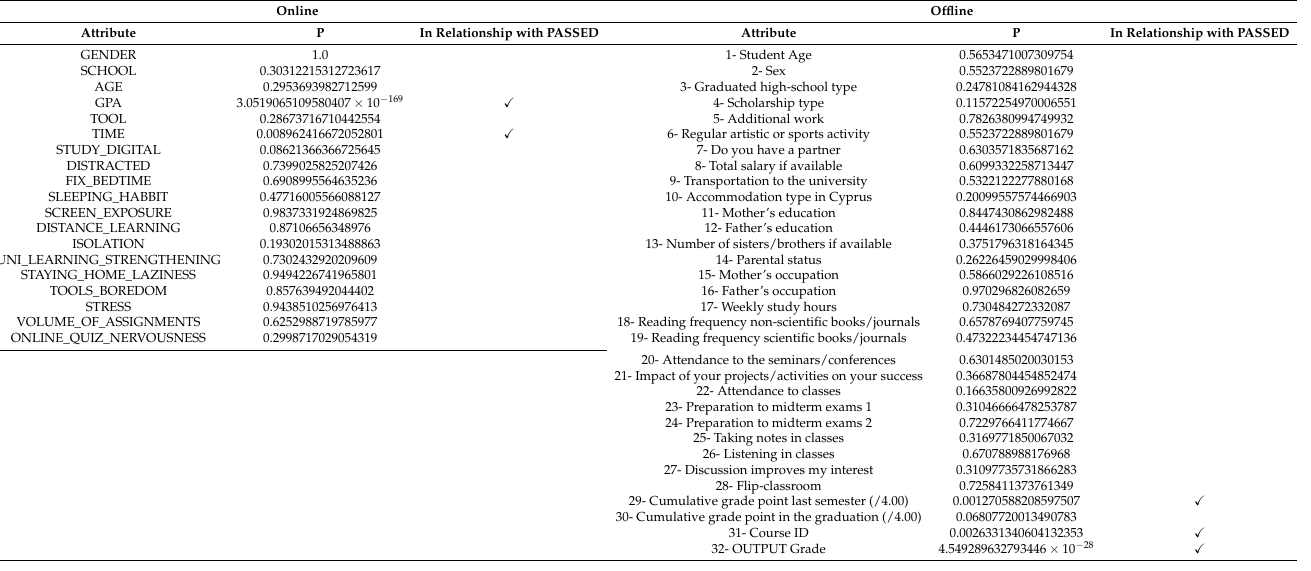
Table 1. Chi-squared test